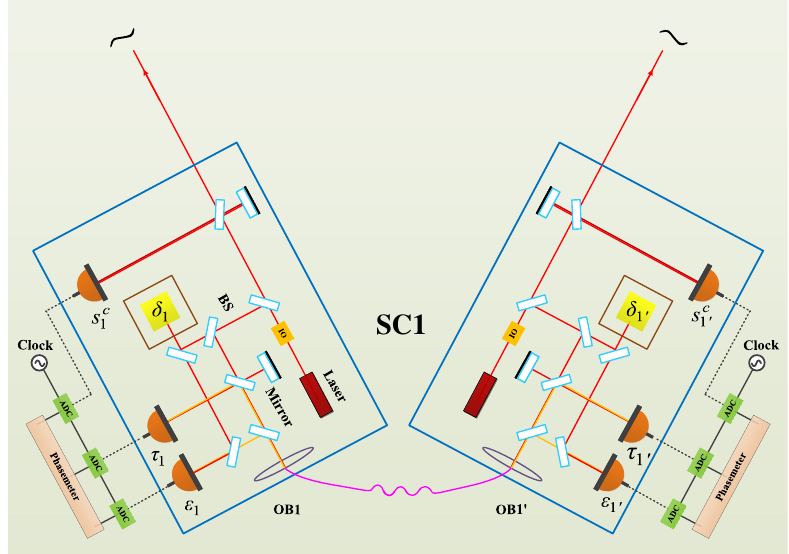
Figure 2. Detailed setup from one of the spacecrafts. BS: beam splitter; SC: spacecraft; OB: opti- cal